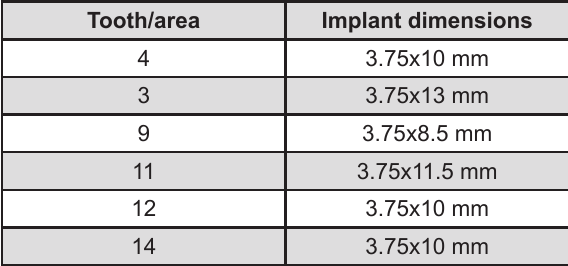
Figure 2- Location and size of implants placed in the